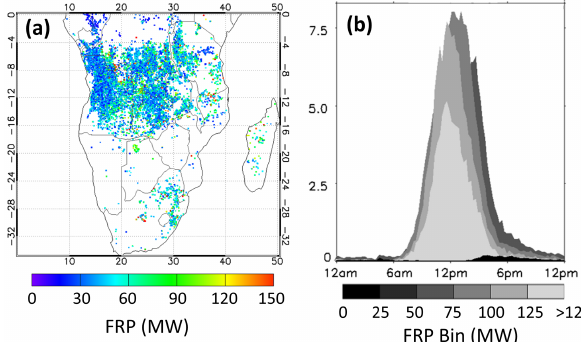
Figure 2. Example data extracted from the LSA SAF Meteosat SE- VIRI FRP-PIXEL product. (a) Active fire locations and their FRP as measured on 17 July 2009 over southern Africa. (b) The same data but now shown as the diurnal cycle of FRP binned into 25MW increments. These data indicate that the individual fire pixel FRP values recorded on this date almost all lay below 150MW and that the peak of the diurnal cycle generally occurred earlier in the day for higher FRP fire